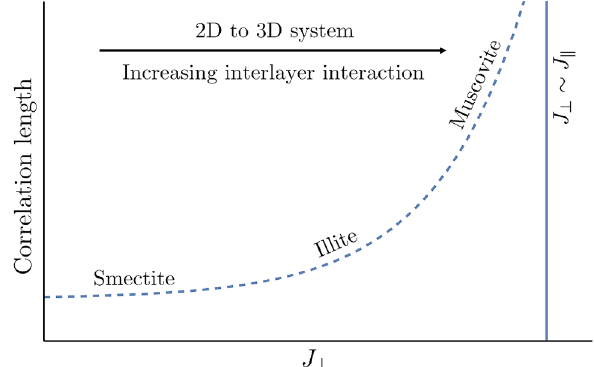
Figure 6. Schematic of the structural transition from a 2D system to a 3D system. As the interlayer interaction J increases, the structural correlation length grows and at a certain point the clay system begins to behave as ⊥ a 3D system instead of a 1D stack of 2D layers. Muscovite has stronger interlayer interactions than smectite or illite and is often observed to have much larger crystal